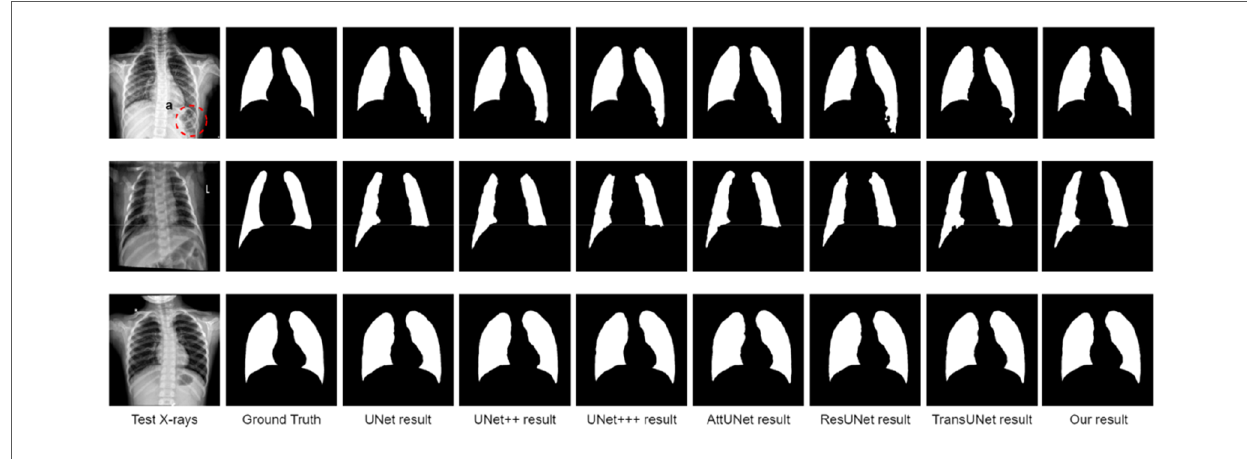
FIGURE 5 Qualitative comparison of different models in the test